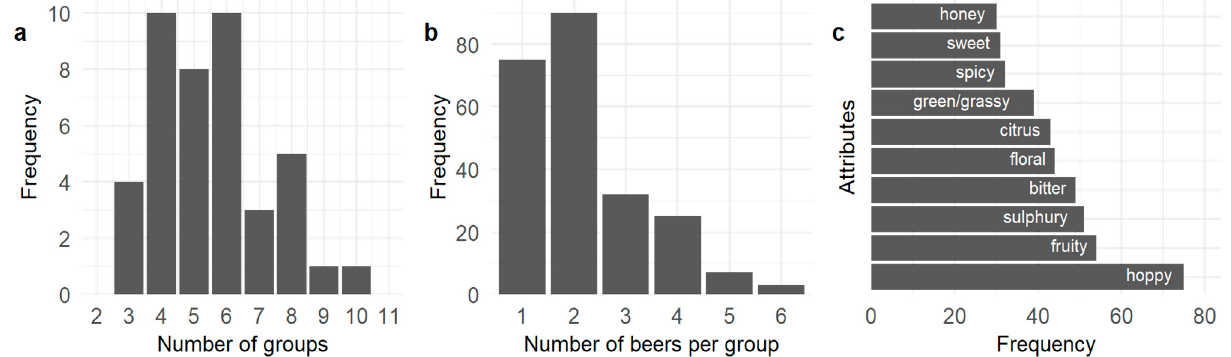
Figure 1. ( a ) Frequency of the number of groups formed by the panelists during the free sorting task (14 panelists × 3 sessions); ( b ) frequency of the number of beers sorted into each group; ( c ) frequency of the ten most commonly used attributes.